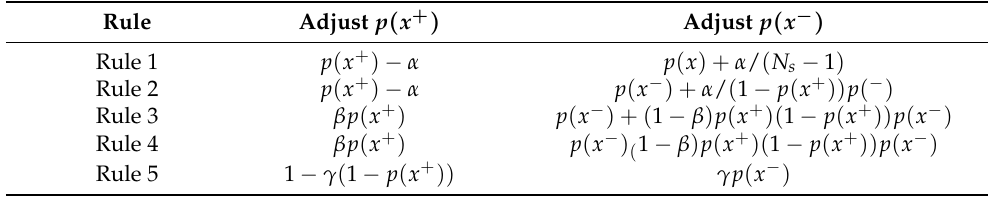
Table 1. Five probability modification rules of degeneration